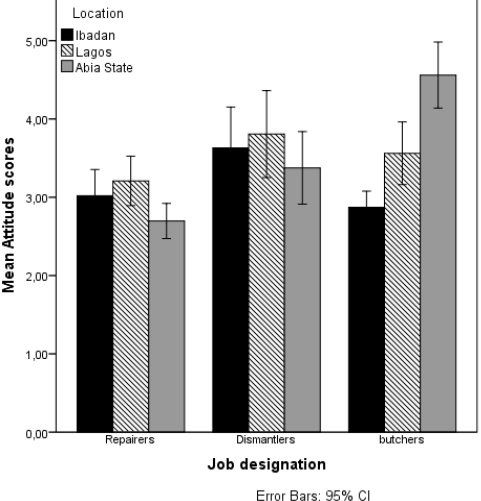
Figure 6. Mean attitude scores by job designation and location.